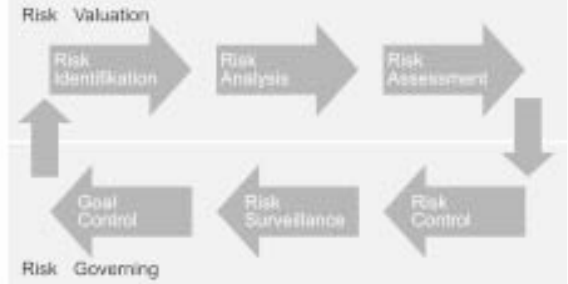
Fig 2 . Elements of risk management